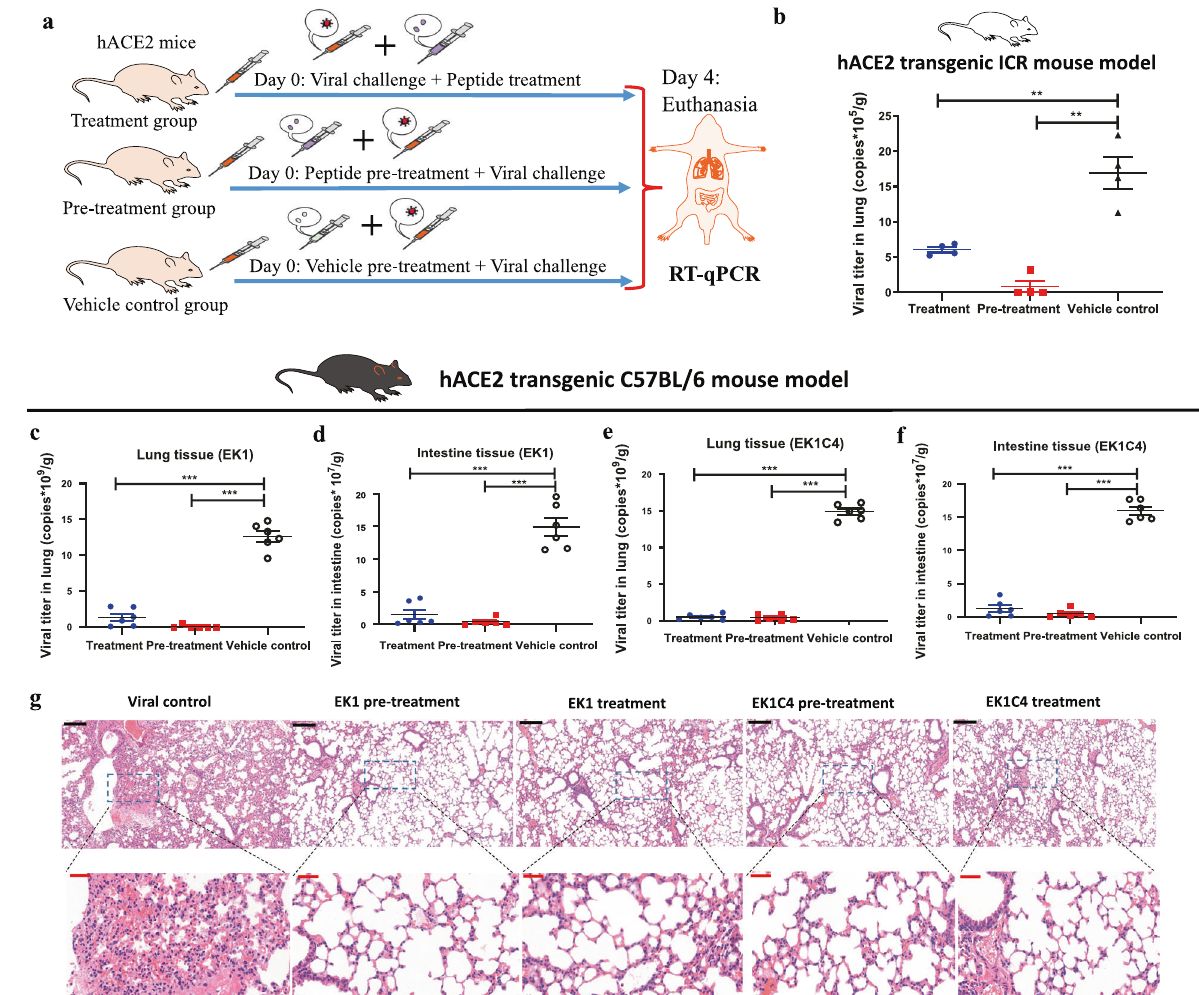
Fig. 3 In vivo prophylactic and therapeutic ef fi cacy of EK1 peptides against SARS-CoV-2 infection in hACE2 transgenic mouse models. a Schematic diagram of EK1 or EK1C4 administration and SARS-CoV-2 challenge. The mice in the treatment group were nasally administrated with a test peptide 30 min after challenge with SARS-CoV-2. The mice in the pre-treatment group and vehicle control group mice were nasally treated with a test peptide or vehicle control, respectively, 30 min before challenge with SARS-CoV-2. b Anti-SARS-CoV-2 ef fi cacy of EK1 (200 μ g/mouse) in hACE2 transgenic ICR mouse model. Viral titer in lung tissue of mice in each group on the 4th day of post-infection was detected. c , d Anti-SARS-CoV-2 ef fi cacy of EK1 (200 μ g/mouse) in vivo on hACE2 transgenic C57BL/6 mouse model. Viral titer in mouse lung ( c ) or intestine ( d ) of each group on the 4th day of post-infection was detected. e , f Anti-SARS-CoV-2 potency of EK1C4 (10 μ g/mouse) in vivo on hACE2 transgenic C57BL/6 mouse model. Viral titer in lung ( e ) or intestine ( f ) of mice in each group on 4th day after SARS-CoV-2 challenge was detected. ** P < 0.01, *** P < 0.001. g Histopathological examination of lung tissue of Tgtn(CAG-human ACE2-IRES-Luciferase) mice with or without administration of EK1 peptides. Lungs from hACE2 transgenic C57 mice were collected on the day 4 of post-infection. The lung tissue sections were stained with hematoxylin and eosin for histopathological examination. Scale bars in black, 200 μ m (upper), scale bars in red, 40 μ m (bottom) post-infection, including alveolar septa thickening and interstitial peptides against SARS-CoV-2 infection. In this mouse model, both in fi ltrates in lung tissue, while EK1 and EK1C4 effectively respiratory and gastrointestinal tissues abundantly express human attenuated these pathological changes in mice receiving prophy- ACE2, 25 thus making it susceptible to SARS-CoV-2 infection and lactic and therapeutic treatment (Fig. 3g). Altogether, our data mimicking the clinical features in human patients. Strikingly, nasal show that EK1 peptides exhibit high in vivo protective ef fi cacy administration of EK1 peptide (200 μ g/mouse) before or after against SARS-CoV-2, as previously reported for HCoV-OC43 and SARS-CoV-2 challenge strongly reduced viral titers in both lung MERS-CoV infection. 20 and intestine, compared with the vehicle control group (Fig. 3c, d). Thus, EK1 peptide exerts prophylactic and therapeutic ef fi cacy against SARS-CoV-2 systemic infection in vivo. Considering that Structural basis for mechanism of EK1 peptides against SARS-CoV- EK1C4 is much more potent than EK1 in inhibiting SARS-CoV-2 2 infection infection in vitro, we proceeded to test the in vivo ef fi cacy of To investigate the inhibitory mechanism of the EK1 peptides, we EK1C4 at lower dosage (10 μ g/mouse). As expected, low dose crystallized EK1 in complex with the HR1 motif of the SARS-CoV-2 EK1C4 treatment ef fi ciently protected against SARS-CoV-2 infec- S2 subunit, which were tandem linked through a 6-residue linker tion in this mouse model (Fig. 3e, f). Notably, the untreated (L6: SGGRGG). This crystal structure of HR1-L6-EK1 was solved by infected mice presented typical histopathology at the 4th day of molecular replacement, using a SARS-CoV-HR1-L6-EK1 structure Signal Transduction and Targeted Therapy (2021)